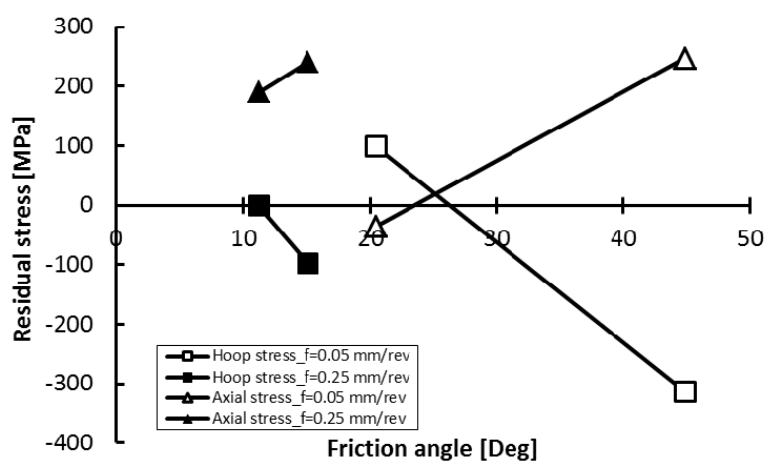
Figure 21. Effect of the friction angle on the surface residual